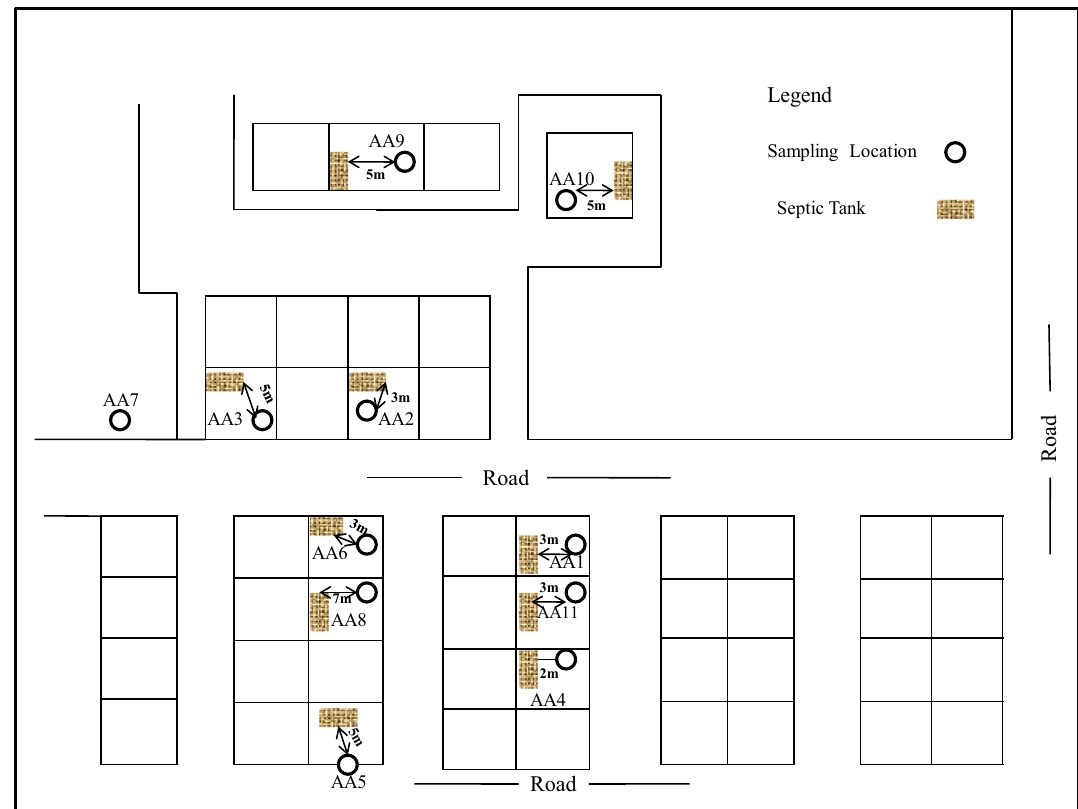
Fig. 3 Schematic map (not to scale) of sampling locations in Ayodhya Kunj,